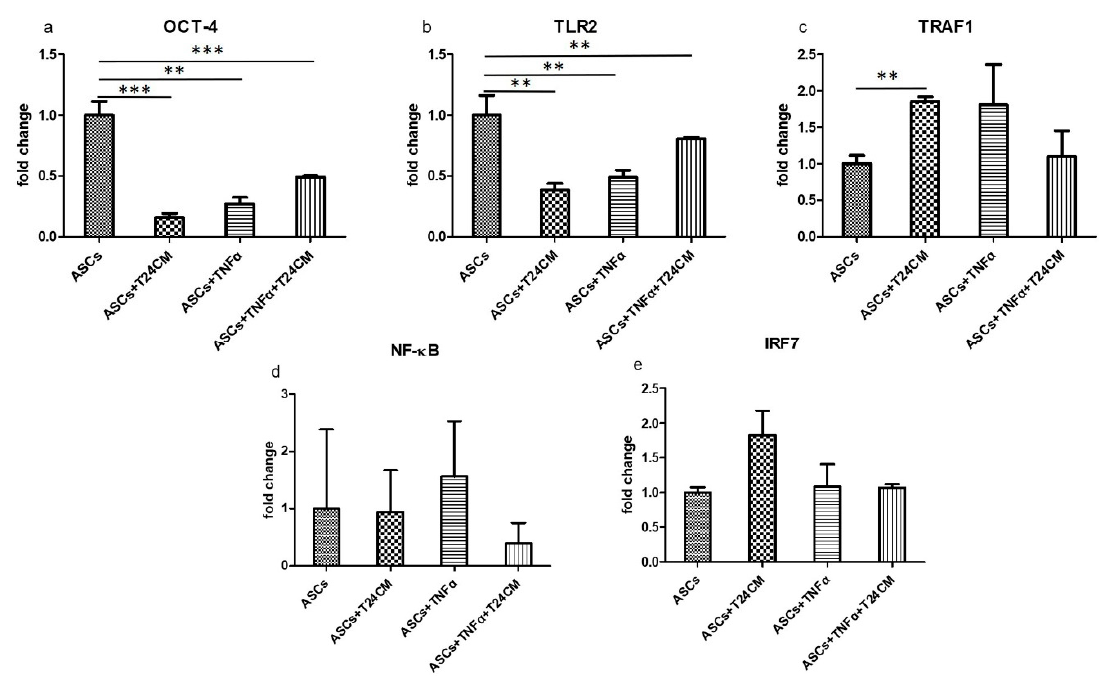
Figure 10. Activation of genes downstream of the Toll-like receptor signaling pathway including ( a ) OCT-4, ( b ) TLR2, ( c ) TRAF1, ( d ) NF- κ B, and ( e ) IRF7 during the incubation of ADSCs and TNF- α -treated ADSCs with bladder cancer cells (T24 cells) medium for 24 h. (** p < 0.01, *** p < 0.001).